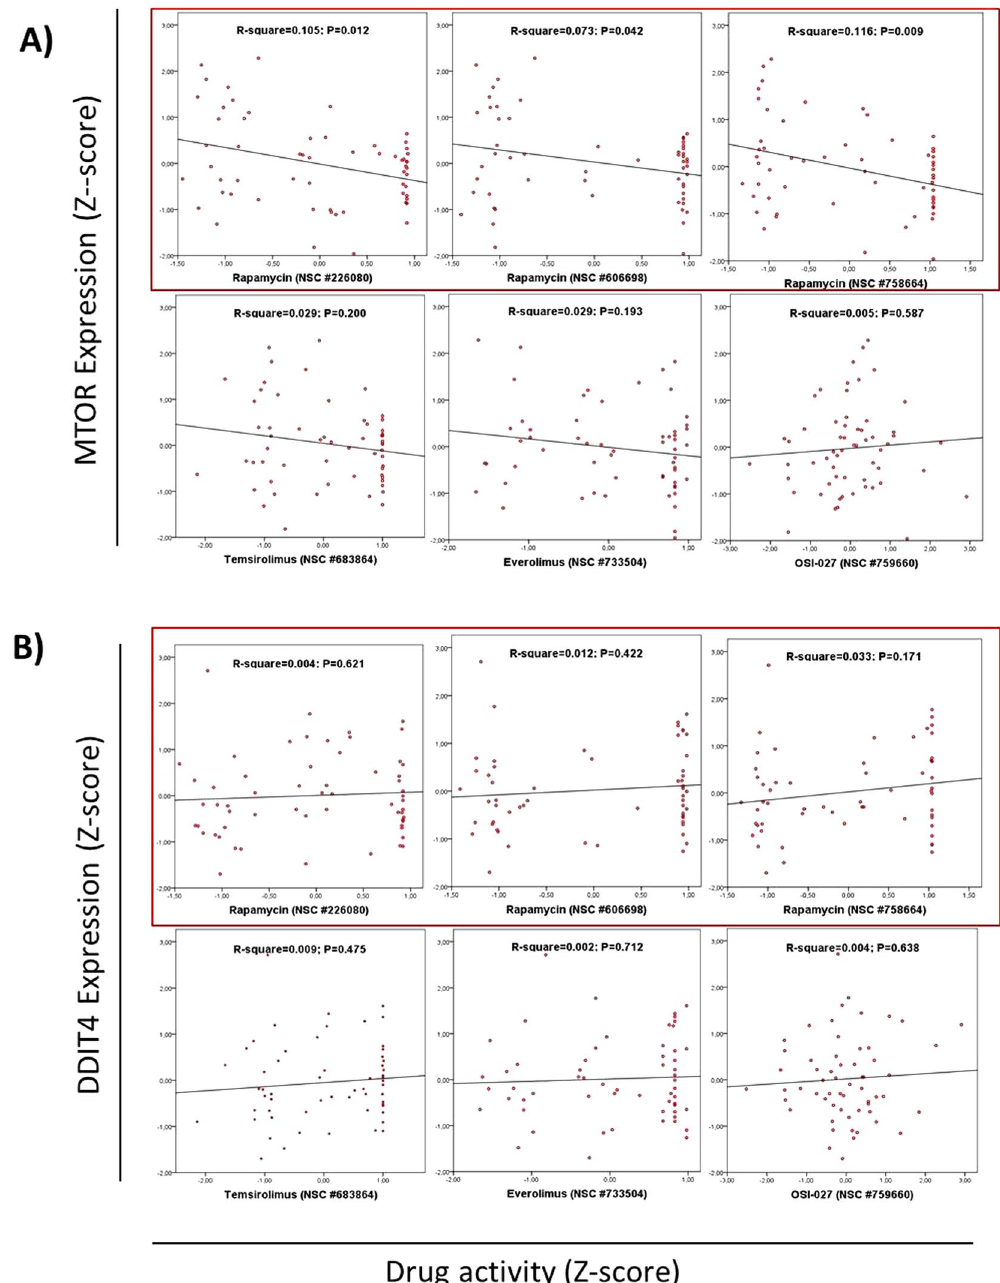
Figure 7. Evaluation of the influence of DDIT4 expression in drug activity of rapamycin. Drug activity of mTOR inhibitors is not influenced by DDIT4 expression in an analysis of 60 cancer cell lines evaluated in Cell Miner Tool. ( A ) mTOR expression is only related to rapamycin response (in a red box). ( B ) DDIT4 is not related with the response to rapamycin (red box) or to the mTOR